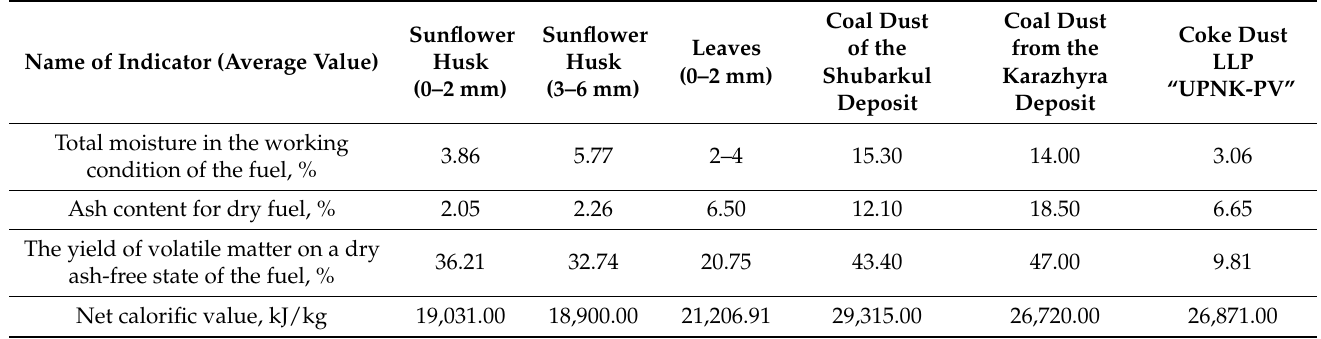
Table 1. Characteristics of feedstock for bio-coal